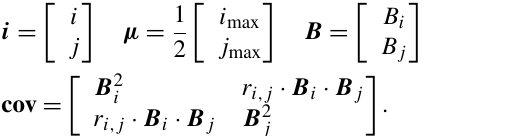
Figure 2. Processing path